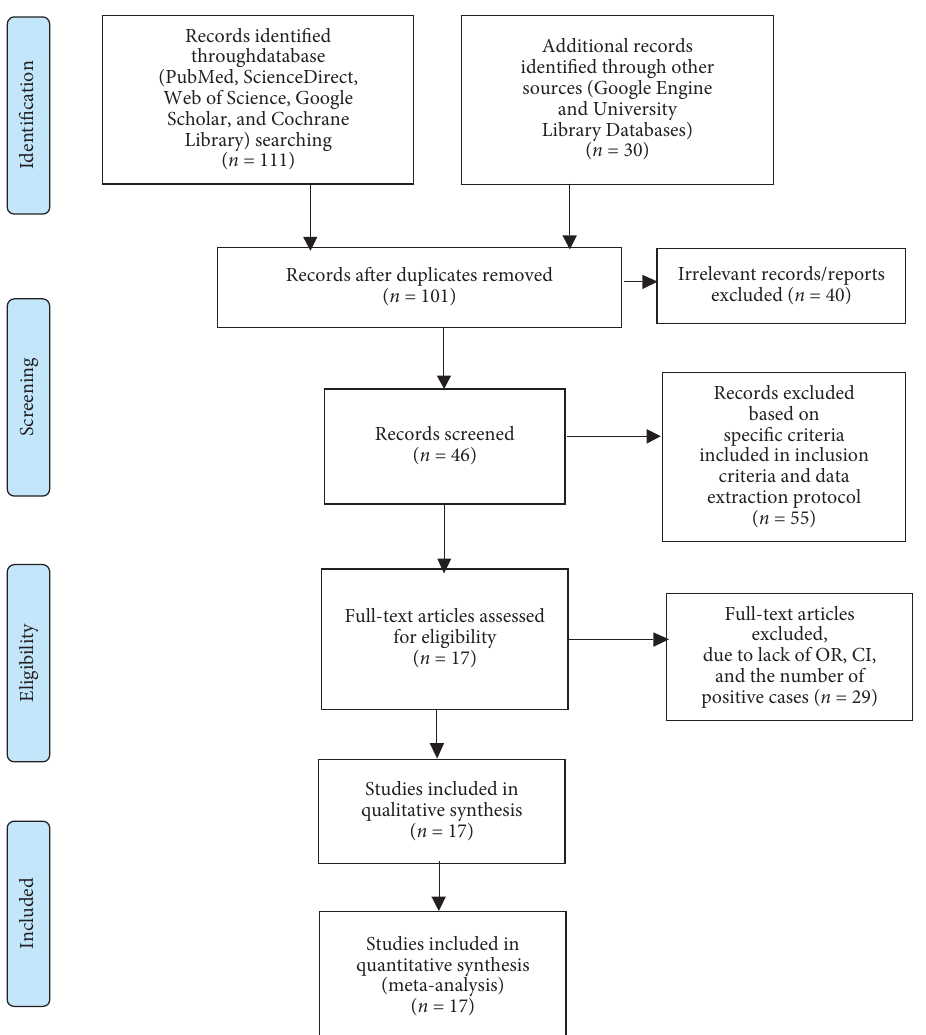
Figure 1: PRISMA 2009 flow diagram of eligible